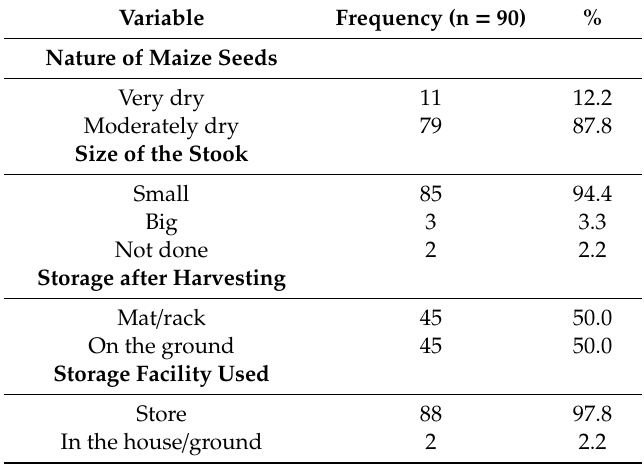
Table 3. Overview of other variables captured in the